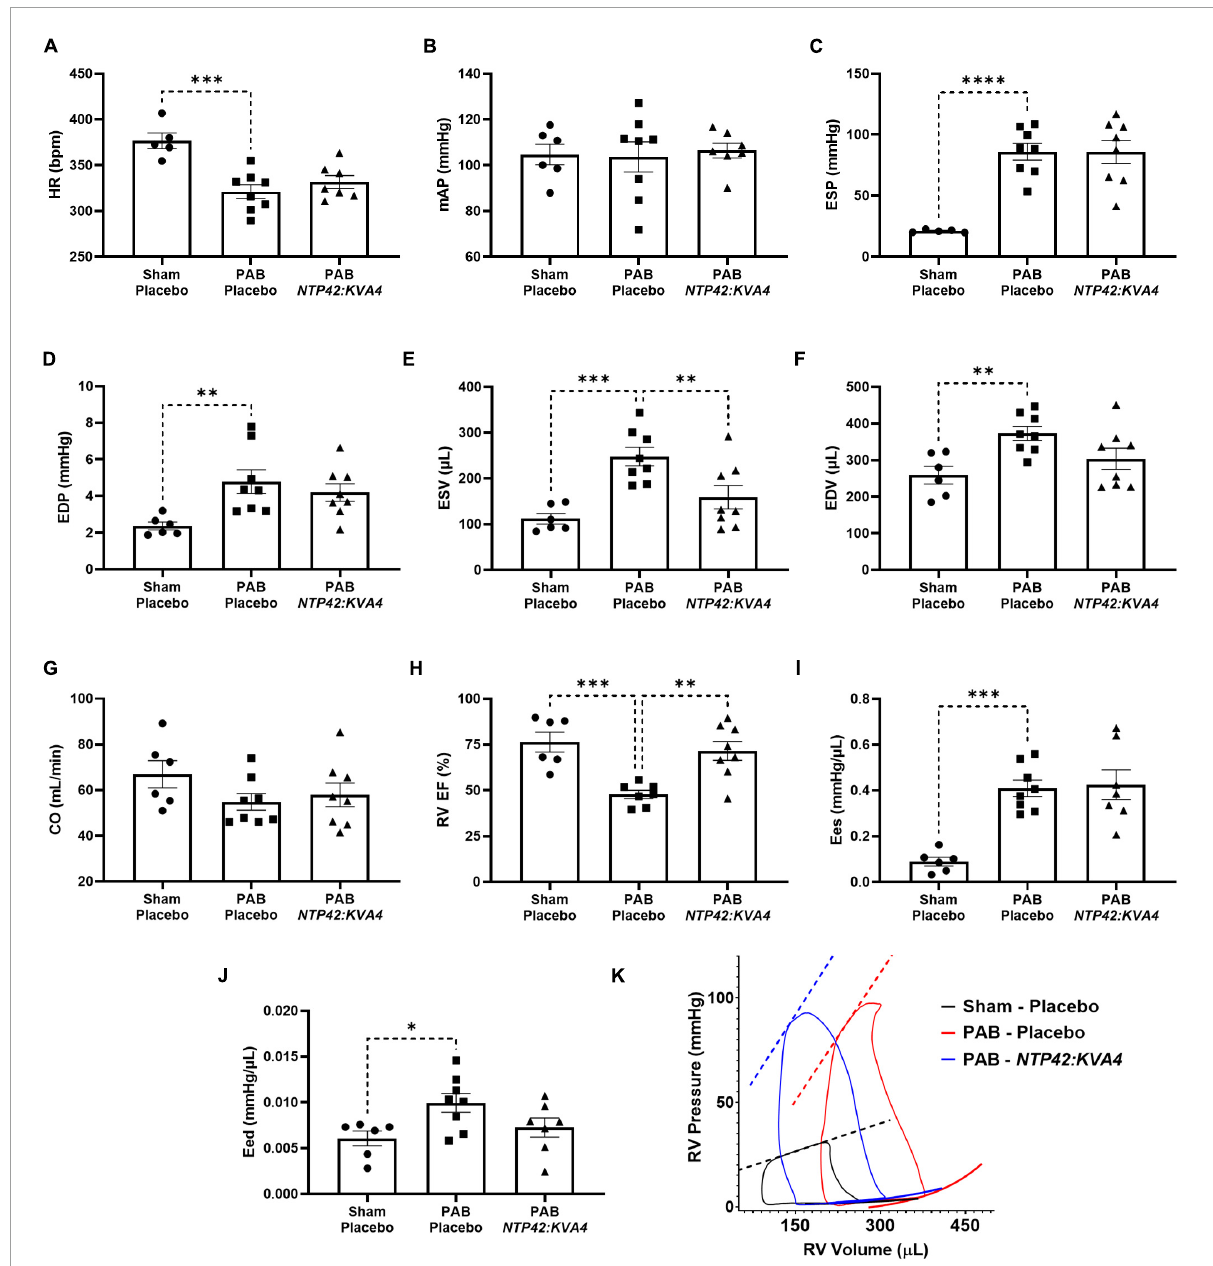
FIGURE3 Effect of NTP42:KVA4 treatment on RV pressure, volume and function in the PAB model. Hemodynamic measurements of: (A) HR in the “Sham—Placebo,” “PAB—Placebo,” and NTP42:KVA4 groups [ n = 5, 8, and 7, respectively]; (B) mAP [ n = 6, 8, 7]; (C) RV ESP [ n = 5, 8, 8]; (D) RV EDP [ n = 6, 8, 8]; (E) RV ESV [ n = 6, 8, 8]; (F) RV EDV [ n = 6, 8, 8]; (G) CO [ n = 6, 8, 8]; (H) RV EF [ n = 6, 7, 8]; (I) RV Ees [ n = 6, 8, 7], and (J) RV Eed [ n = 6, 8, 7]. Data presented are the mean ± SEM. * P < 0.05, ** P < 0.01, *** P < 0.001, **** P < 0.0001 vs. “PAB—Placebo,” according to one-way ANOVA with Holm-Šídák correction. (K) shows representative RV PV loops from PAB study animals. The linear end-systolic and exponential end-diastolic PV relationships within each group are displayed as thick dashed or solid lines, respectively. Maximum/minimum PV points on the displayed representative loops, and the PV relationships plotted thereon, were adjusted to correspond approximately with the average values determined within treatment group.